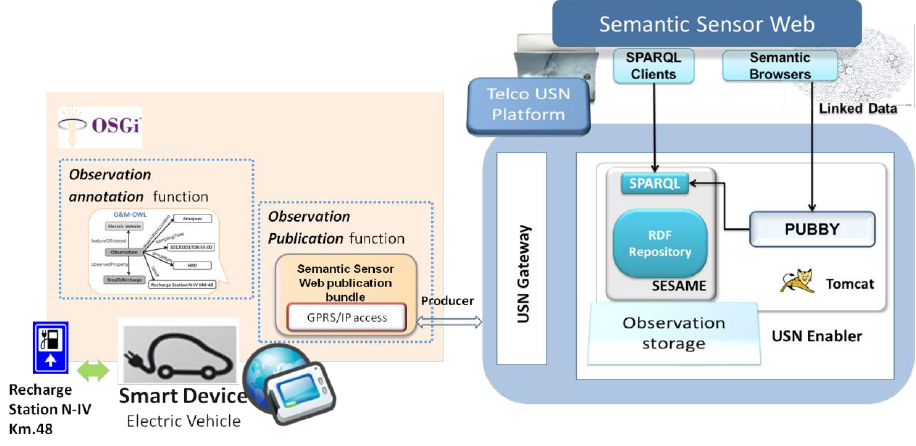
Figure 6. Implementation of the Telco USN-Platform to provide semantic web